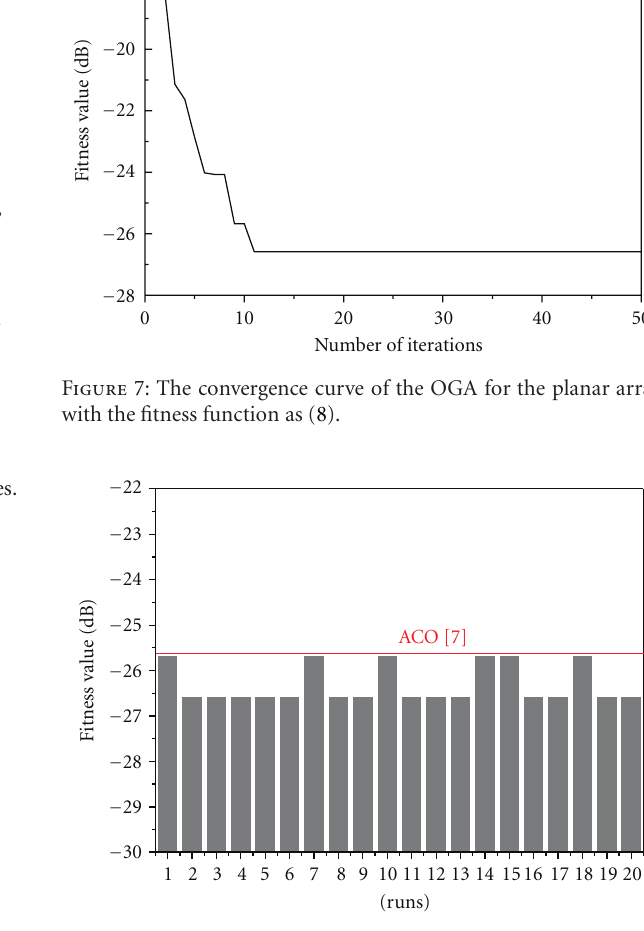
Figure 8: The fitness value of the objective function with (8) ob- tained by the OGA in 20